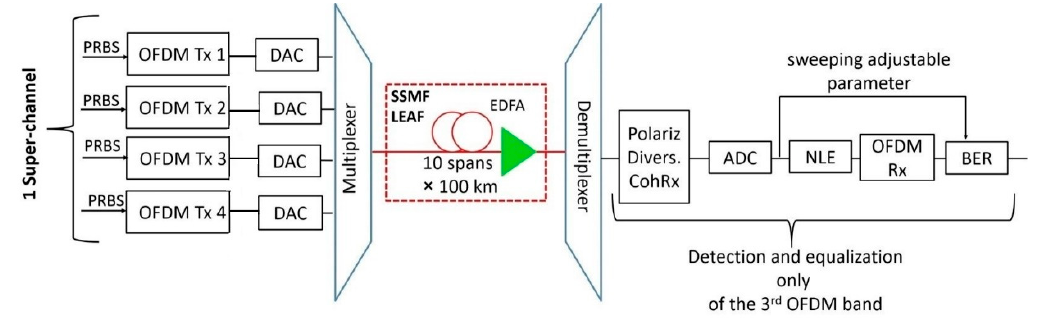
Figure 4. Simulation setup of a 4-band, single-polarization, OFDM super-channel using as a transmission link either an SSMF or a LEAF. (Abbreviations: pseudo-random bit sequence (PRBS), OFDM transmitter (OFDM Tx), digital-to-analog converter (DAC), standard single-mode fiber (SSMF), large effective area fiber (LEAF), erbium-doped fiber amplifier (EDFA), polarization-diversity coherent receiver (Polariz. Divers. CohRx), analog-to-digital converter (ADC), nonlinear equalizer (NLE), OFDM receiver (OFDM Rx), and bit-error-rate (BER).